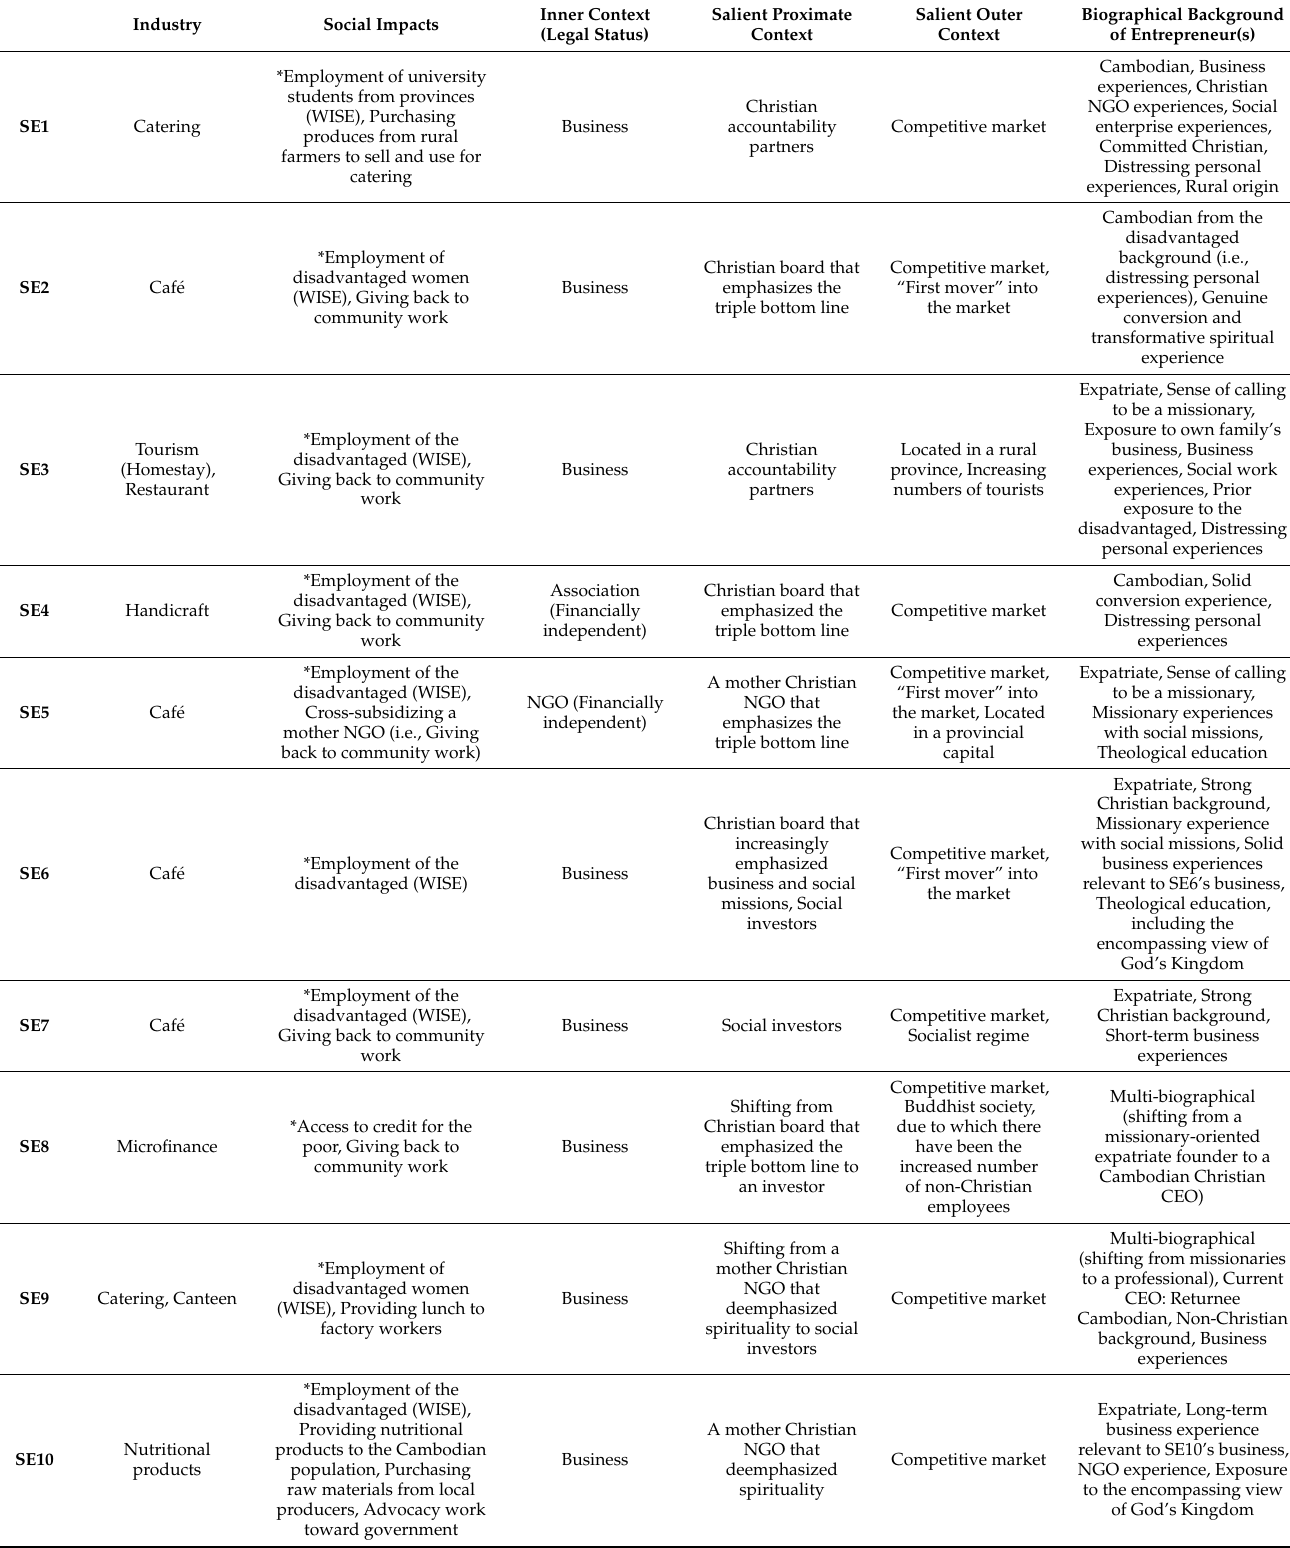
Table 1. Attributes and variables of sample Christian social